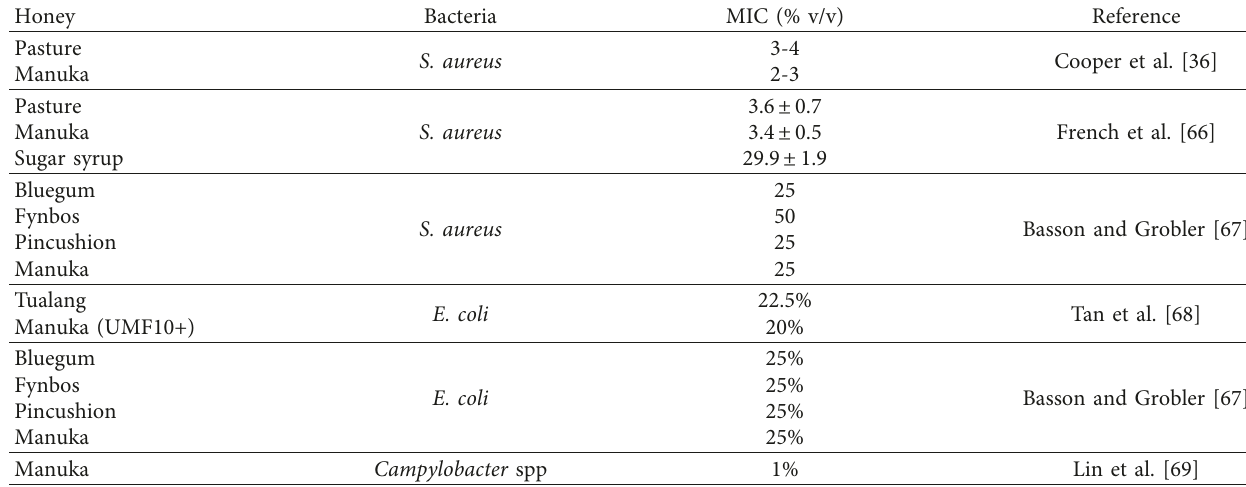
Table 3: Studies on the antibacterial activity of